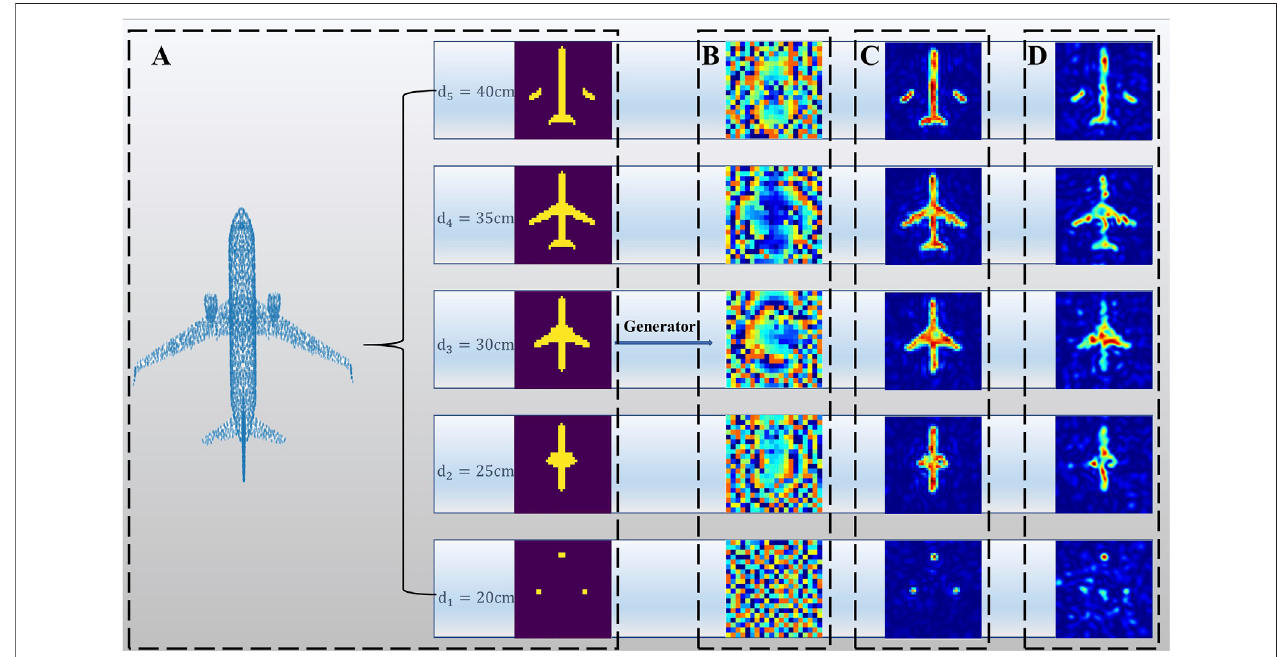
FIGURE5|(A) Three-dimensionalairplanemodelsegregatedintotwo-dimensionalImagesat fi vedifferentdistances (B) Hologramsyieldedbygeneratorbasedon images and distances (C) Diffraction imaging results obtained via numerical simulation at corresponding distance (D) Full-wave simulation results based on supercell obtained via CST.